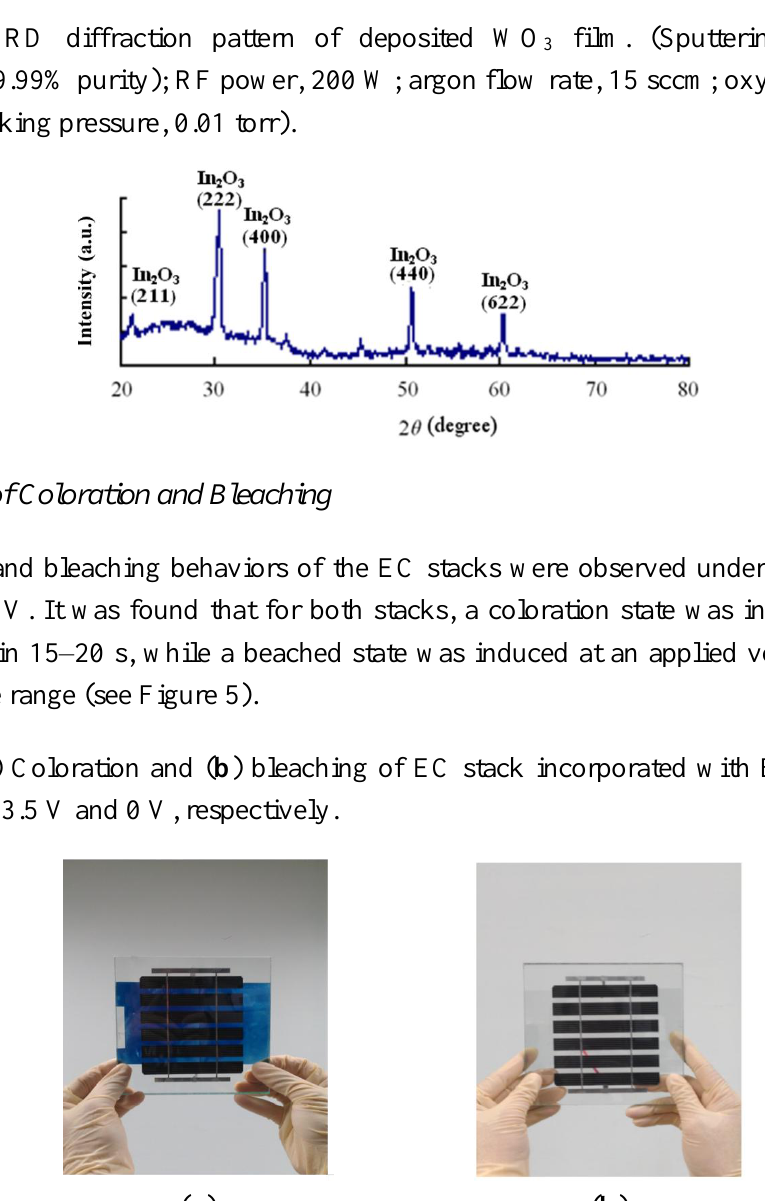
film. (Sputtering conditions: 3